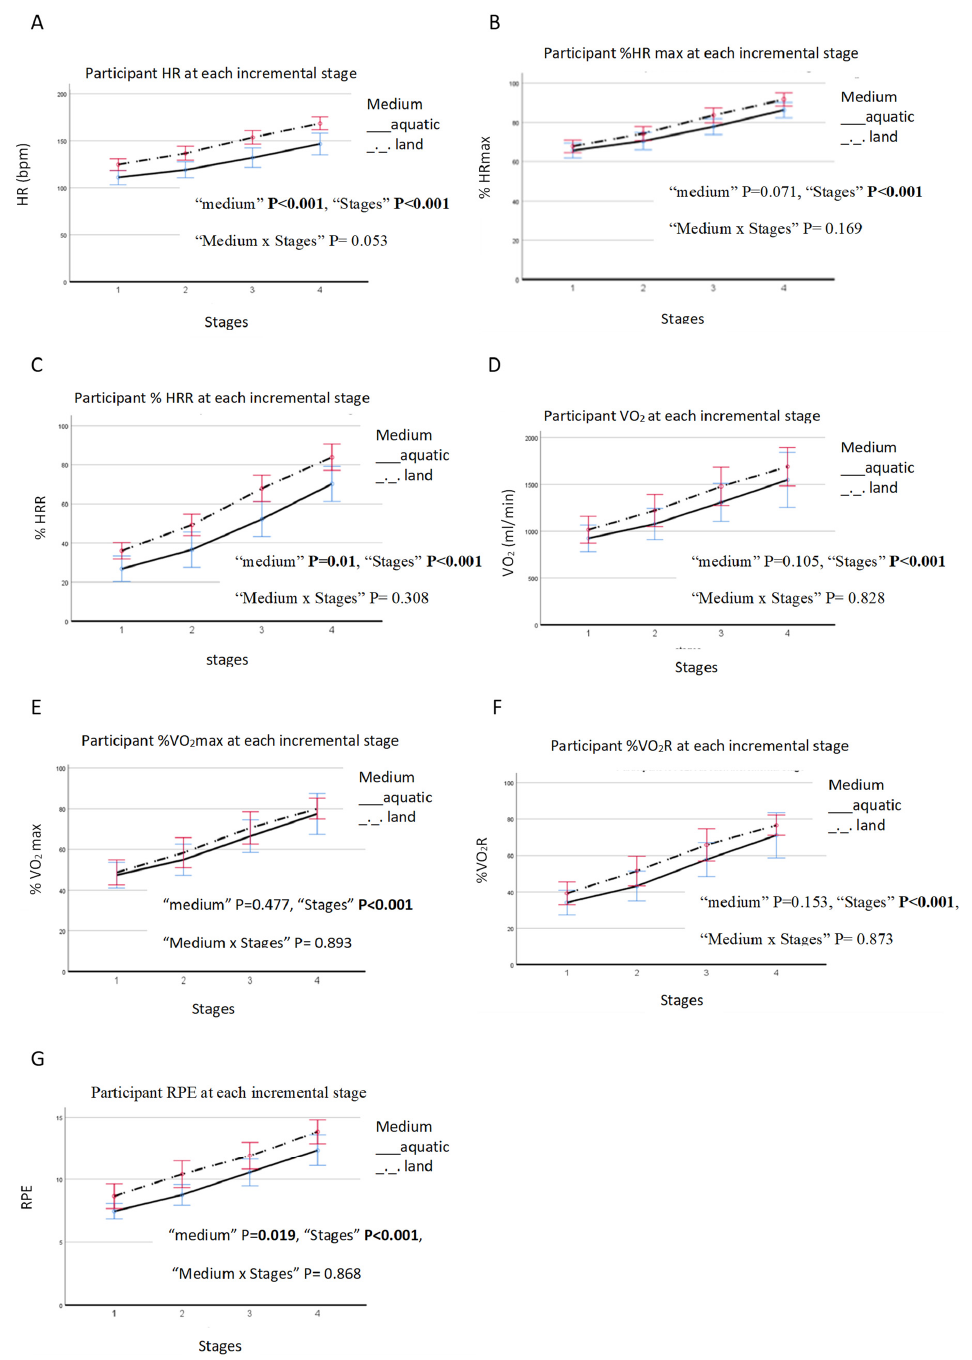
Figure 1. Aquatic VS land incremental tests: ( A ) HR, ( B ) %maxHR, ( C ) %HRR, ( D ) VO 2 , ( E ) %VO